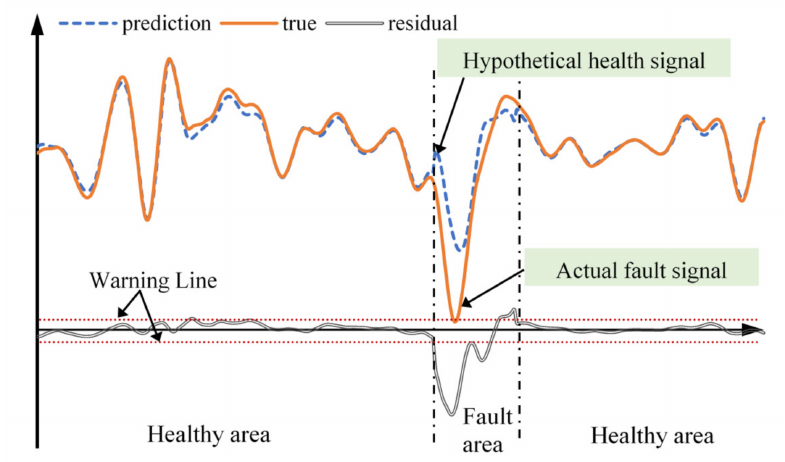
Figure 3. Setting the principle of signal anomaly recognition of threshold value.